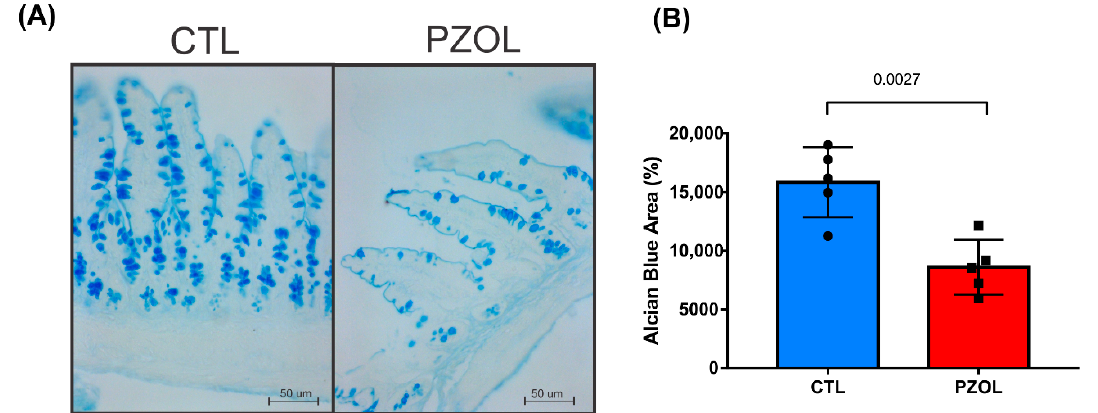
Figure 7. Pantoprazole induced loss of intestinal barrier functions. ( A ) Representative alcian blue (pH 2.5) stained section in the ileum: CTL and PZOL groups; ( B ) AB quantification graph of CTL and PZOL groups expressed as mean ± standard deviation t -test statistical comparisons. Images obtained with 20× objective. ( n = 5 animals per group).